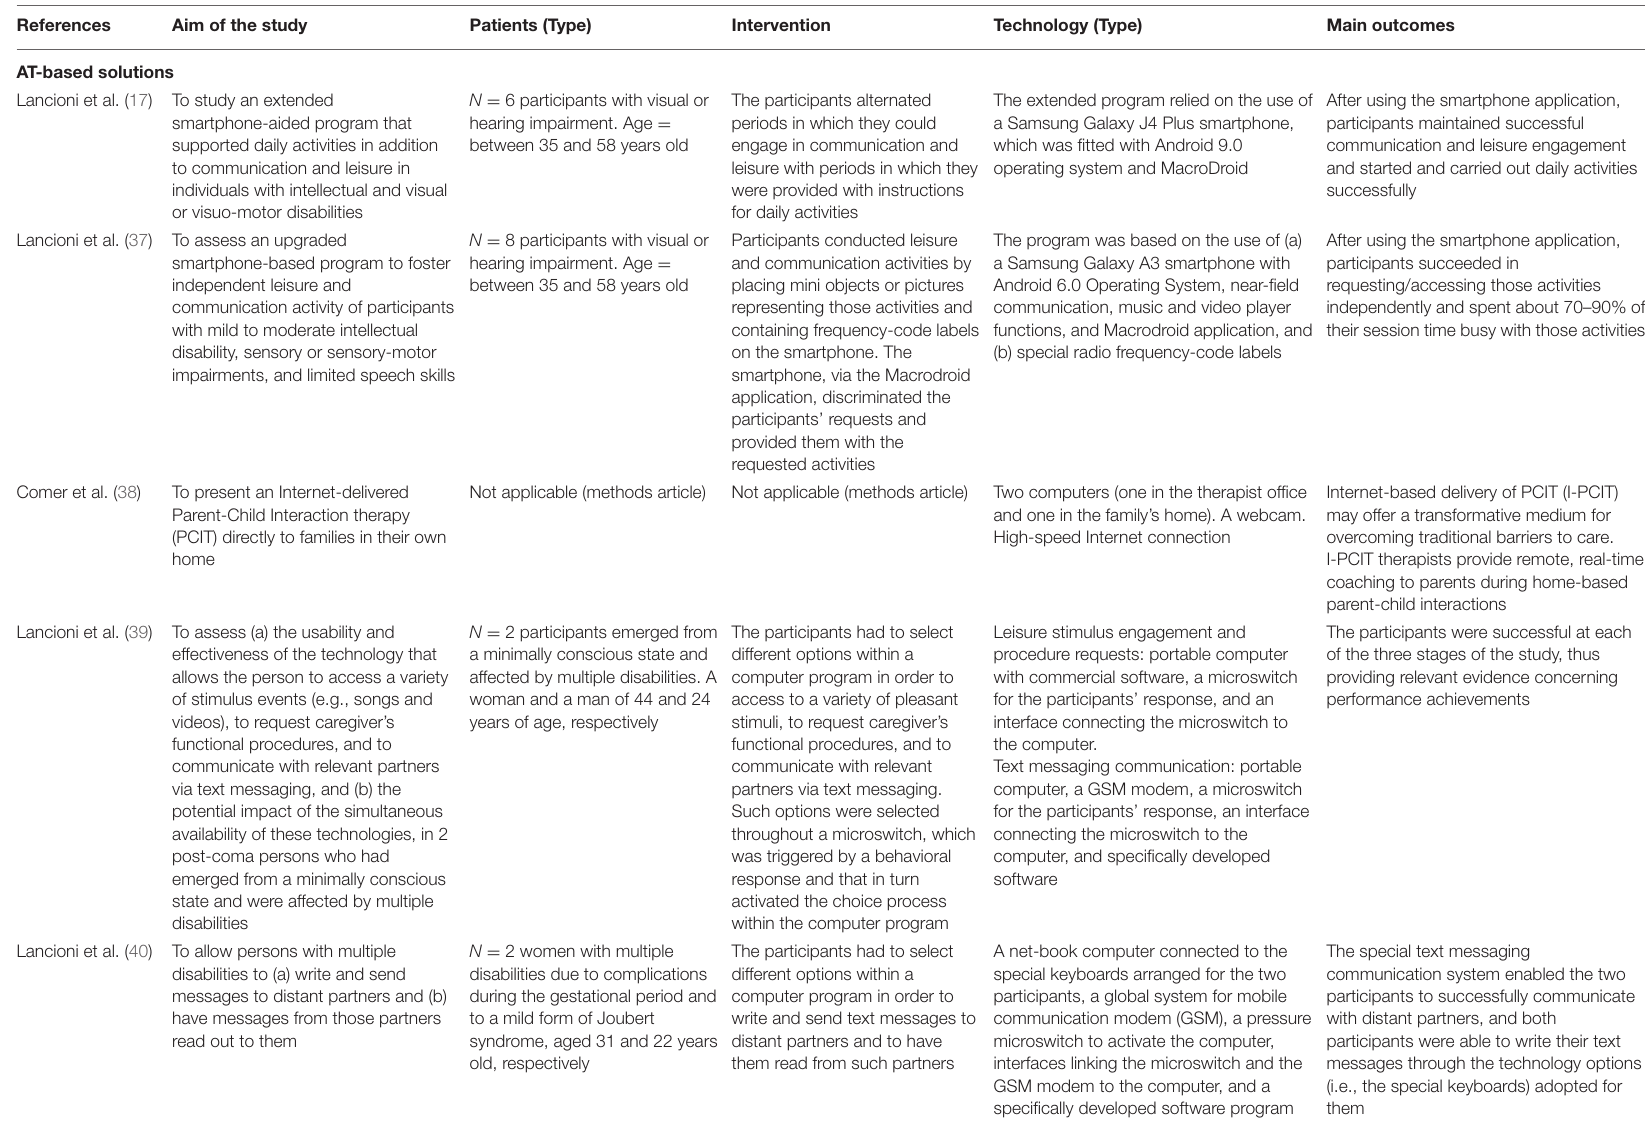
TABLE 1 | Studies integrating AT-based and VR solutions to improve communication in individuals with neurodegenerative diseases and acquired brain